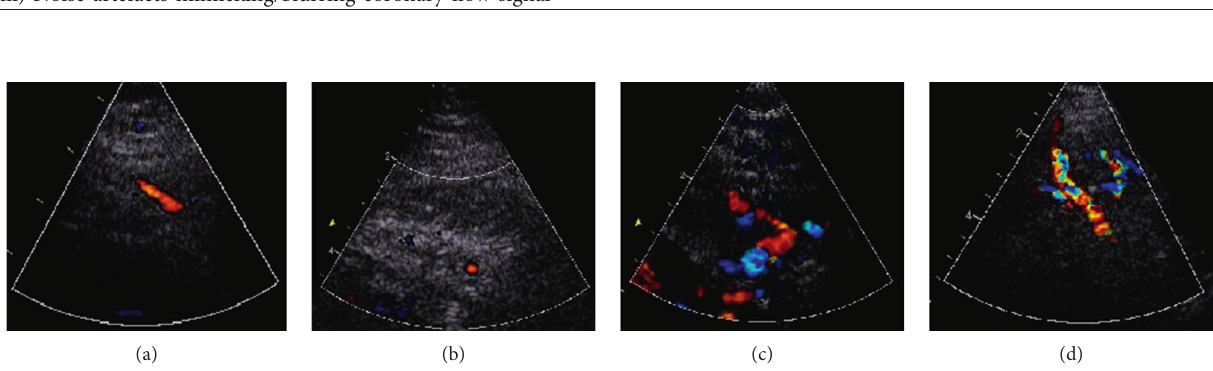
Figure 2: 2D color Doppler view of the left anterior descending artery (LAD) demonstrating the importance of artery identification and alignment for accurate CFVR estimation. (a) Optimal visualization of the LAD segment in a foreshortened two-chamber view. Suboptimal artery identification compromising quality of CFVR evaluation: (b) only a short segment of the artery visible; (c) tortuous artery; and (d) multiple vessels in the same